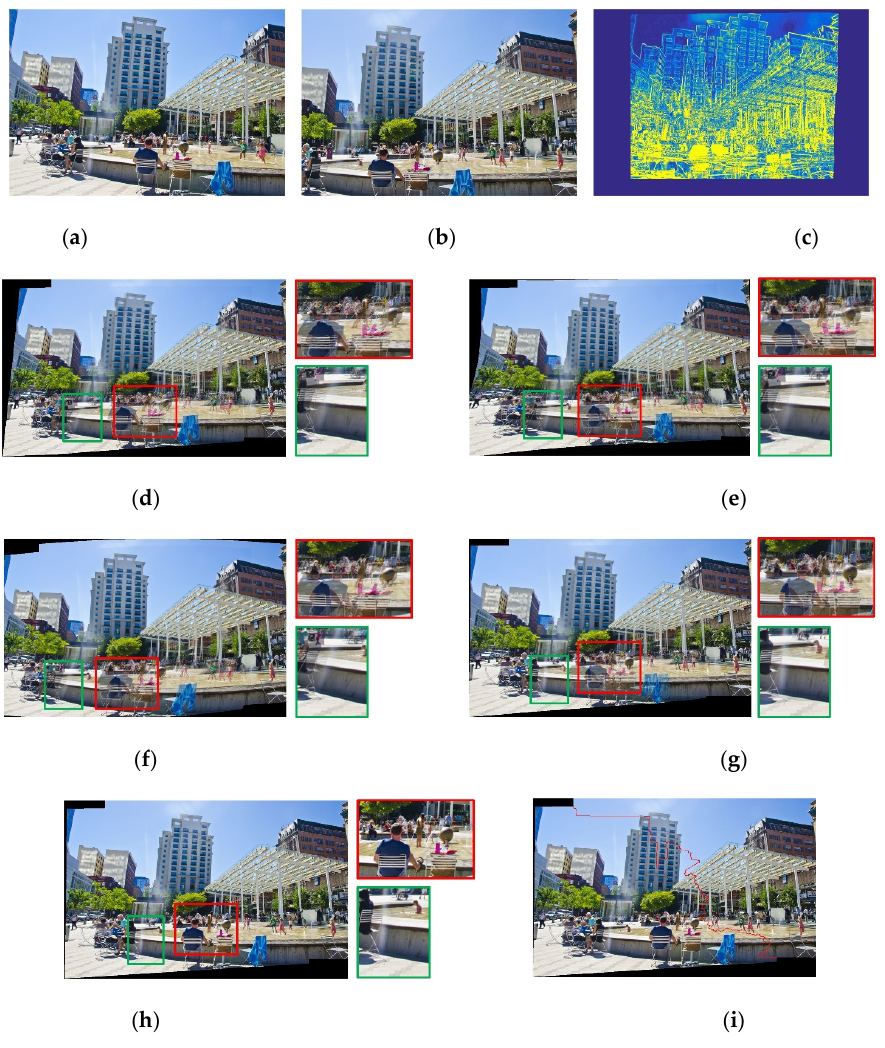
Figure 4. The stitching results of different methods. ( a , b ) Two input images to be stitched. ( c ) Dif- ference cost of the overlapping region obtained with the proposed method, where heat map is used for clear display. ( d ) Results of APAP [10]. ( e ) Results of AANAP [11]. ( f ) Results of REW [12]. ( g ) Results of SPW [13]. ( h ) Results of the proposed method. ( i ) The seam obtained with the proposed method.